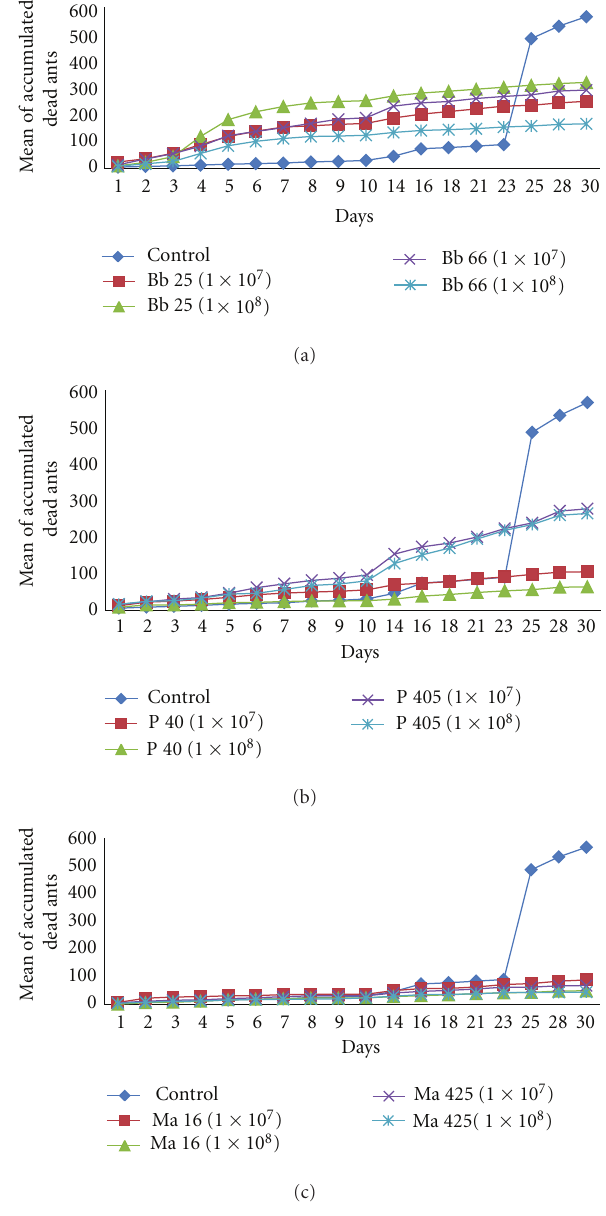
Figure 2: Mean of cumulative mortality of Monomorium floricola workers, from five experimental colonies, submitted to the appli- cation of entomopathogenic fungi in di ff erent concentrations. Bb: Beauveria bassiana ; P: Paecilomyces sp. Ma: Metarhizium anisopliae.